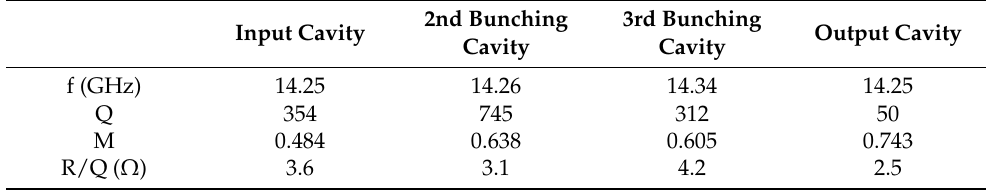
Table 1. Parameters of the multiple cavities RKA.